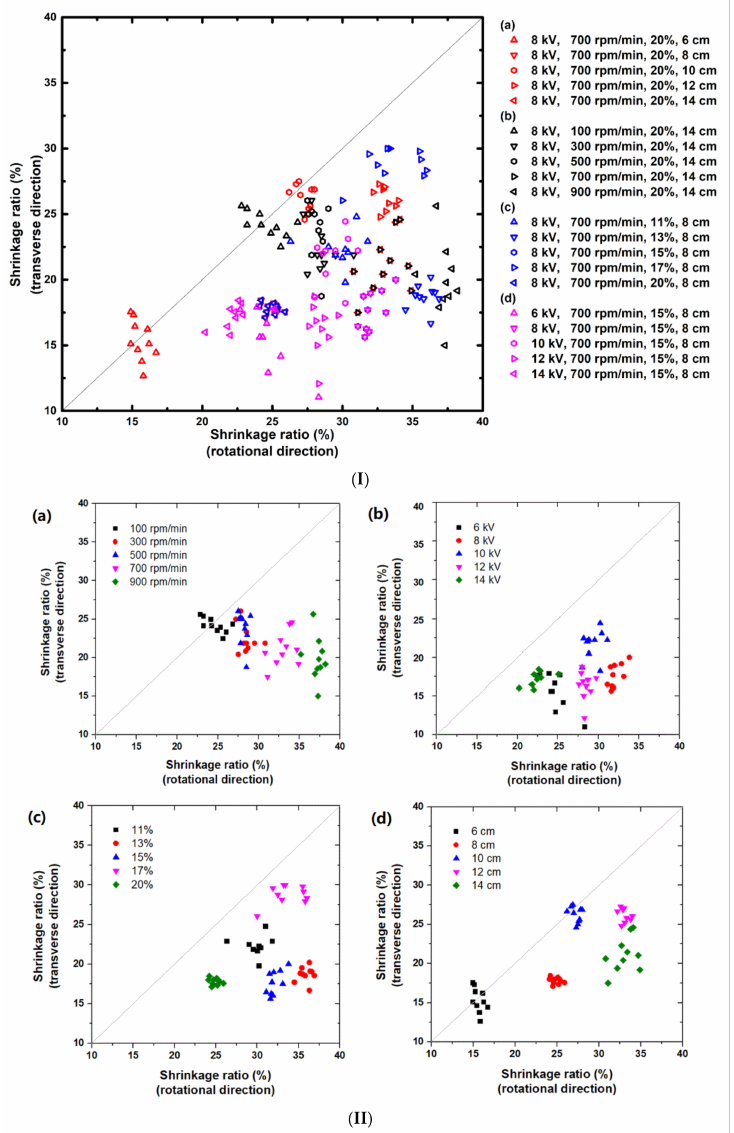
Figure 5. Shrinkage ratio along the rotational direction versus shrinkage ratio along the transverse direction (solution flow rate: 1.2 mL/h). ( I ) Overlapping of all experimental results; ( II ) results of parametric study. ( a ) Rotation speed of collector; ( b ) applied voltage; ( c ) solvent concentration; ( d ) distance between